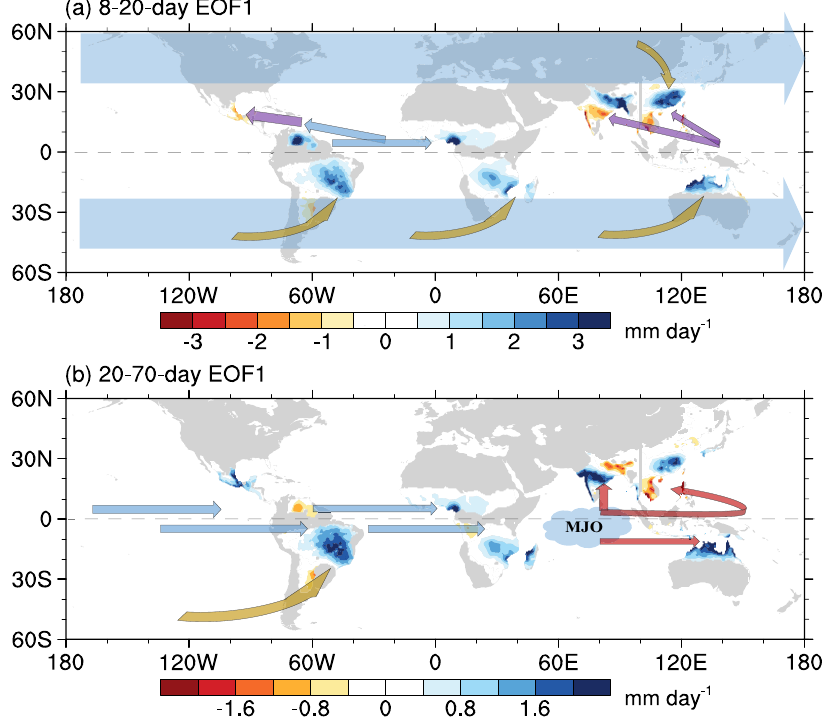
Fig. 9 Schematic diagram of propagation routes for dominant ISV modes of individual summer monsoons. Thin arrows show the propagation routes before the wet peak phase of leading ISV mode (same shading as in Fig. 3) in each monsoon region. The purple and red arrows illustrate the preceding quasi-biweekly oscillation in a and MJO in b , respectively. The eastward and westward blue arrows indicate the preceding equatorial Kelvin and mixed Rossby-gravity waves, respectively. The yellow arrows indicate the mid-latitude intraseasonal Rossby waves. The broad light-blue arrows in a denote the background westerly zones where mid-latitude wave trains